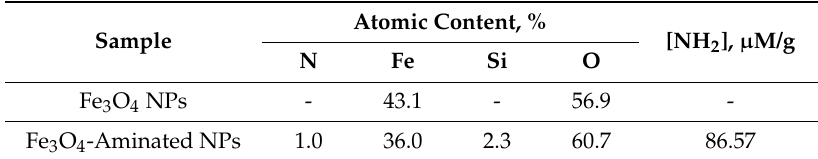
Figure 3. Characteristics of the functionalized magnetic nanoparticles: ( a ) Schematic representation of the modification of magnetic nanoparticals by organosilicon compound (APTMS); ( b ) FTIR spectra, ( c ) XRD diffractogram; ( d ) size distribution; ( e ) Mössbauer spectra; ( f ) distribution of the hyperfine magnetic field; ( g ) hysteresis loop. Table 1. Element ratio variations by using the EDX method of magnetic nanoparticles and after modification with